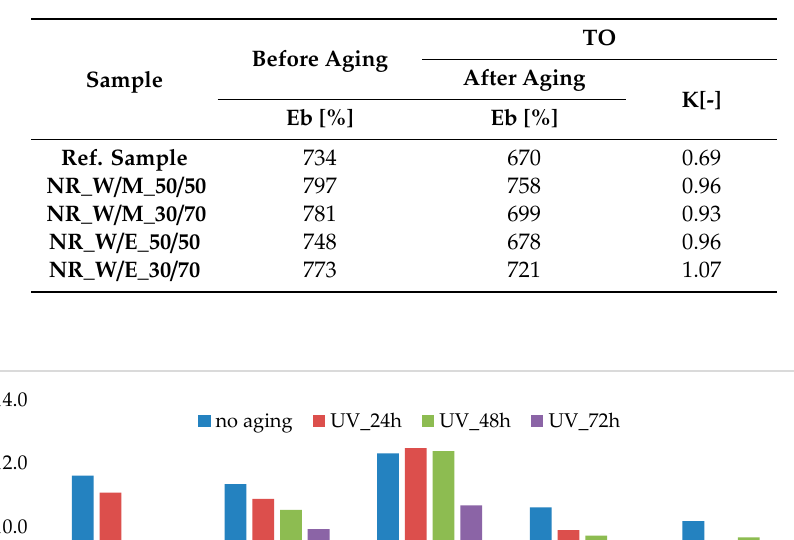
Table 6. Elongation at break of vulcanizates before and after simulated thermo-oxidative aging process and aging factor (K).